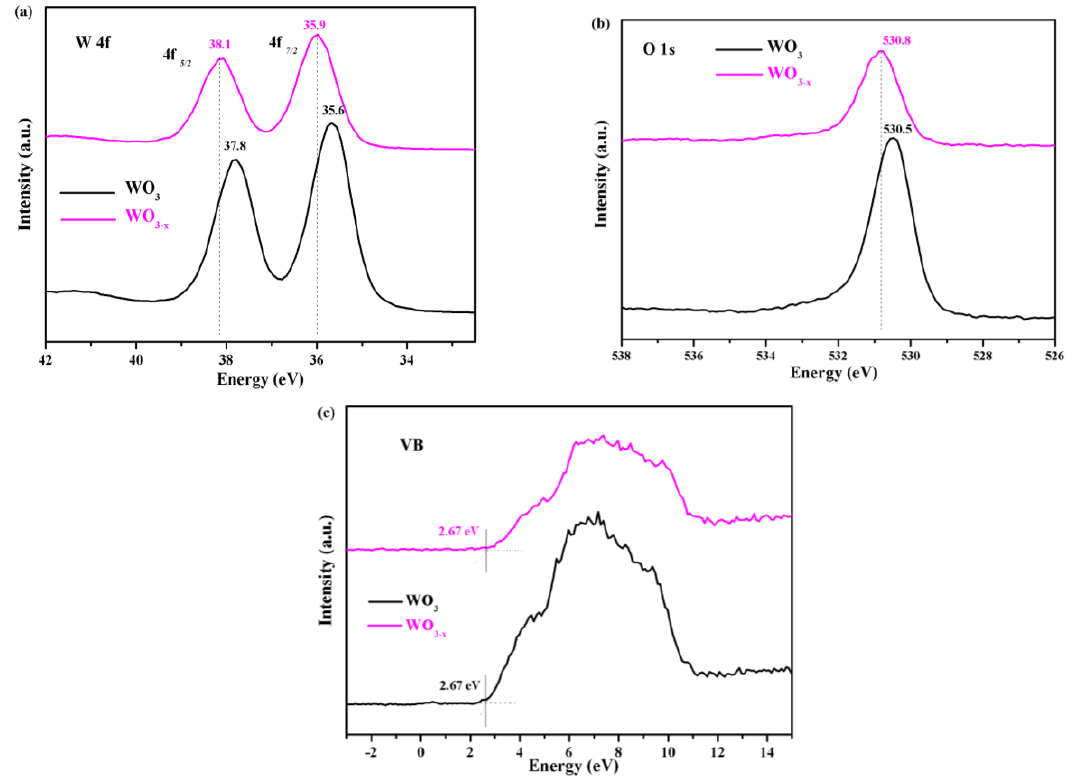
Figure 5. ( a ) The Ti 2p X-ray photoelectron spectra (XPS) spectra of the as-prepared WO 3 and WO 3 − x